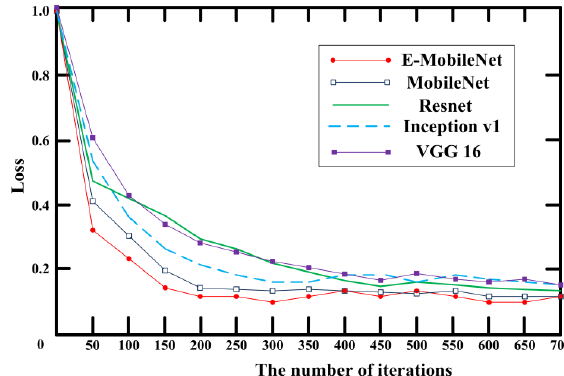
Figure 14. Convergence curve.